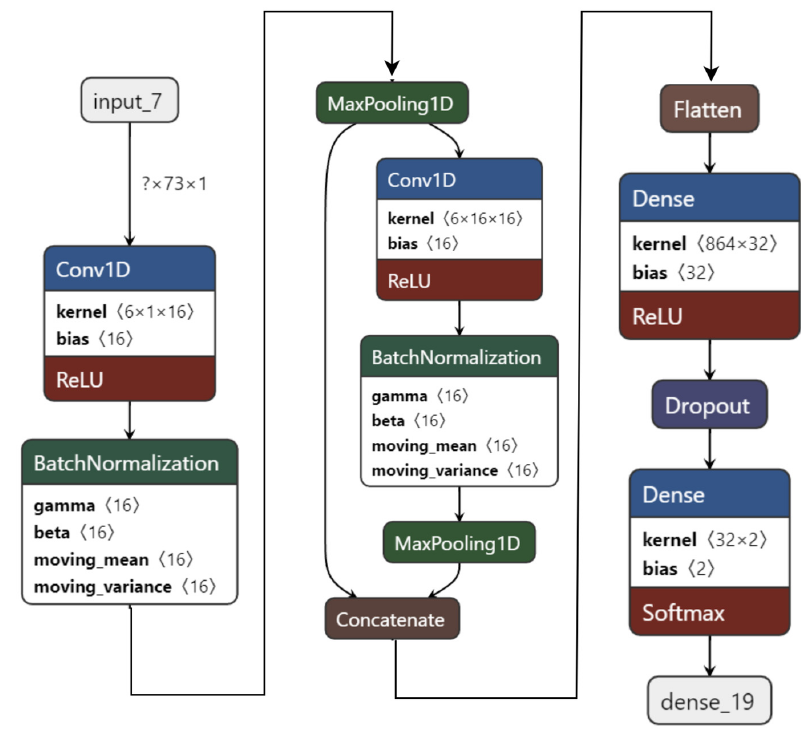
Figure 8. M2 model: 1D CNN model with 2 convolution and 1 dense